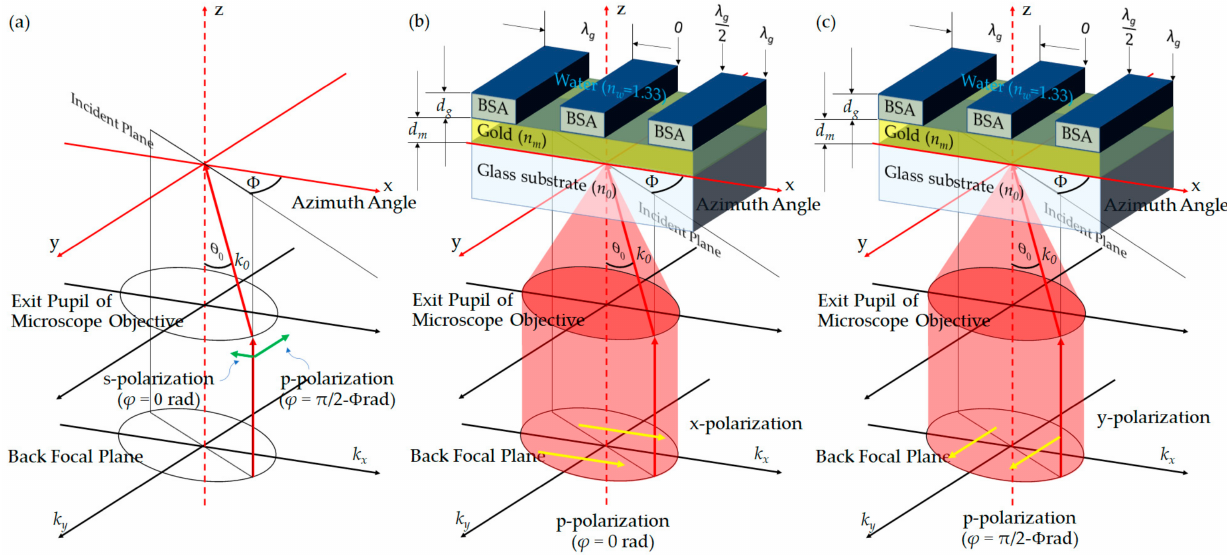
Figure 3. Shows ( a ) optical incidence and polarization direction, ( b ) x-polarization in the BFP, and ( c ) y-polarization in the